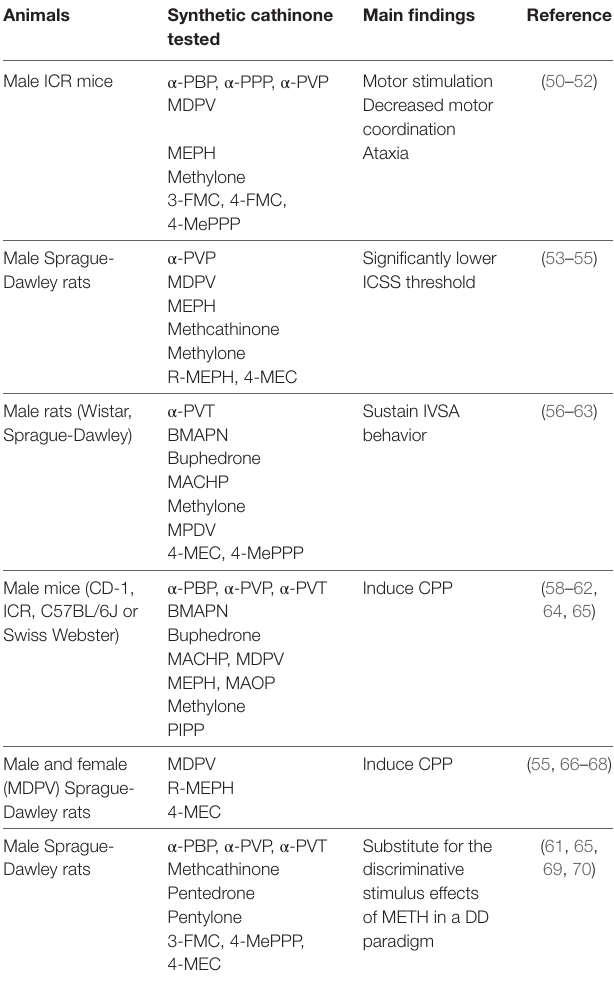
TabLe 1 | Studies investigating the behavioral effects of synthetic